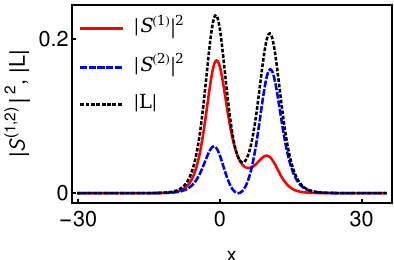
Figure 15. Asymmetric double-hump profile of the nondegenerate fundamental soliton in a 2- component LSRI